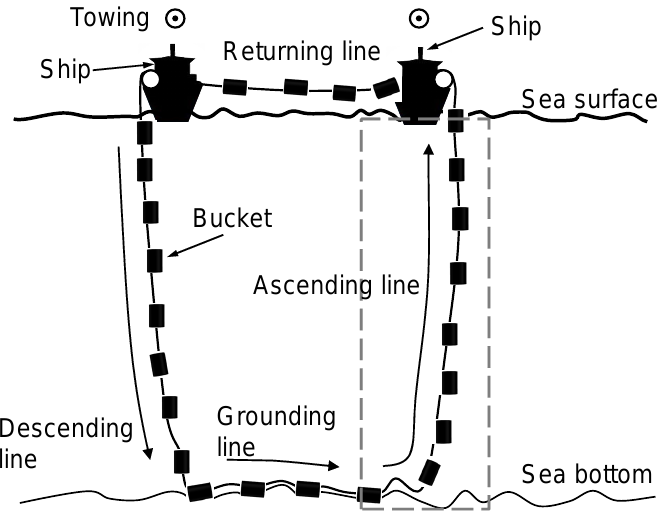
Figure 1. Schematic of a two-ship continuous line bucket (CLB) system. The circular cable comprises two suspended parts (ascending and descending parts) and a grounded part. The dashed box represents the ascending part addressed in this